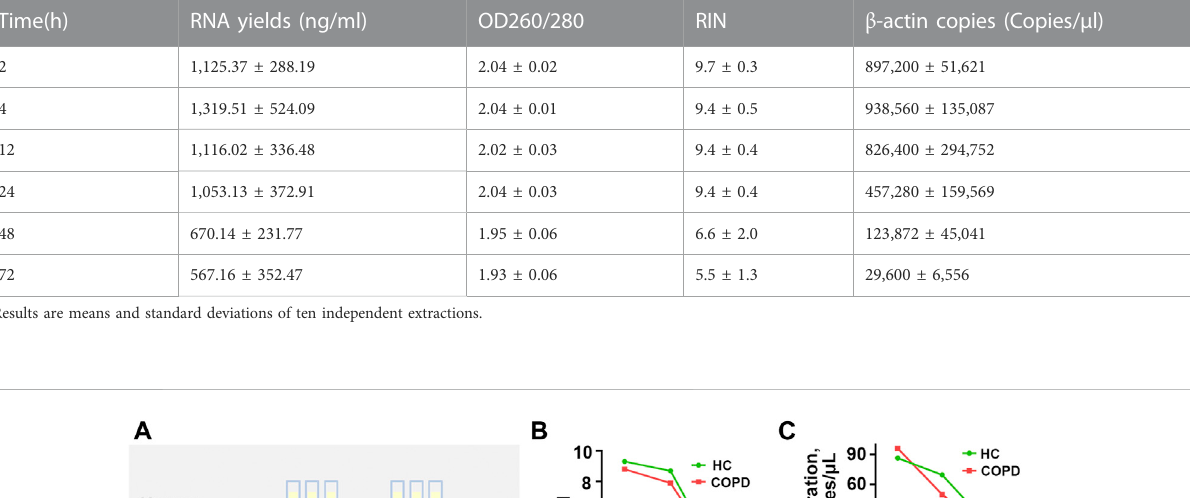
TABLE 2 Blood placed at RT over 12 h signi fi cantly compromised PBL-derived RNA quality a . Time(h) RNA yields (ng/ml)